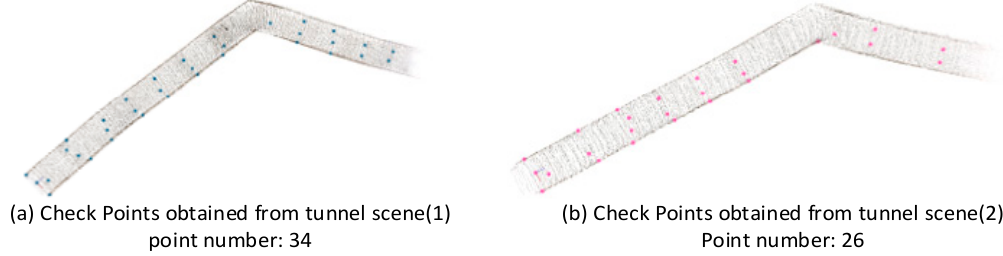
Figure 9. Tunnel scenes, marked with the checkpoints, ( a ) checkpoints obtained from tunnel scene (1); ( b ) checkpoints obtained from tunnel scene (2).